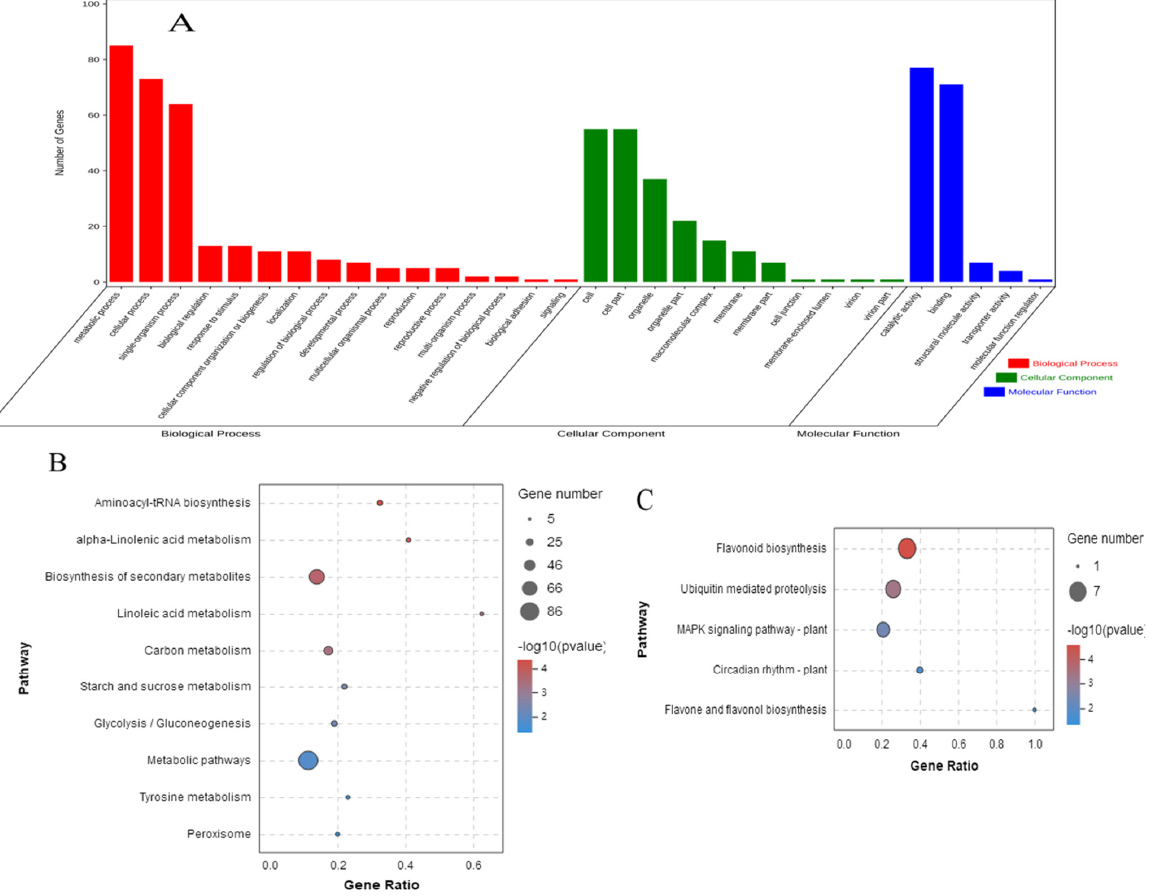
Figure 6. ( A ) GO ‐ based enrichment analysis of differentially expressed proteins (DEPs) in leaves of Rhododendron delavayi under drought stress; ( B ) Significantly enriched ( p < 0.05) pathway of up ‐ accumulated DEPs under drought stress; ( C ) Significantly enriched ( p < 0.05) pathway of down ‐ accumulated DEPs under drought stress.